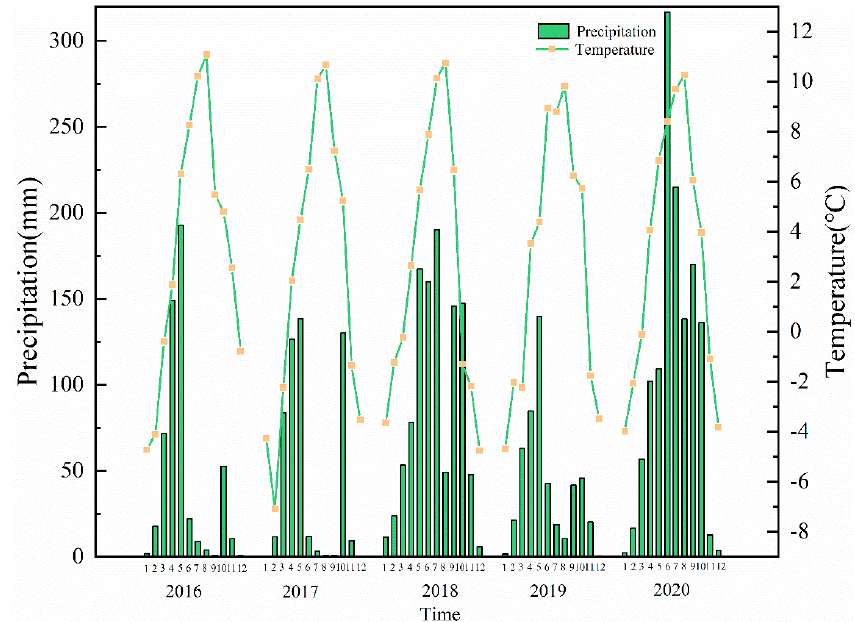
Figure 1. Mean monthly air temperature and rainfall of the Long-term Research Station of Alpine Forest Ecosystems from 2016–2020.